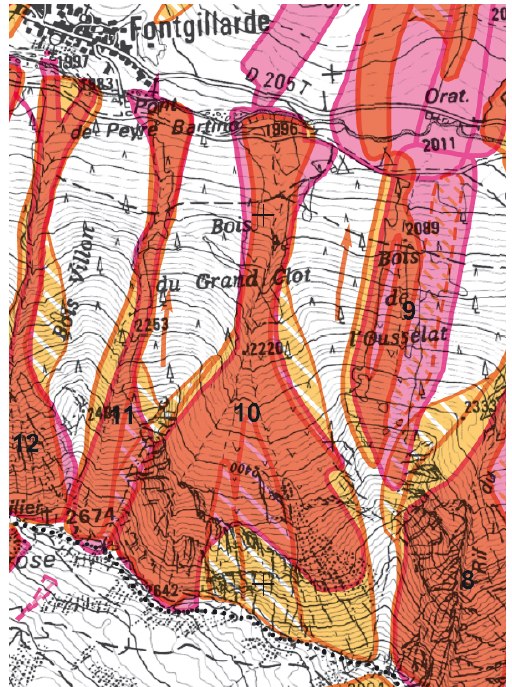
Figure 3. The Localization Map of Avalanche Phenomena (CLPA) in Molines-en-Queyras township. The CLPA path number 10 corre- sponds to the EPA path number 7 presented in Fig. 1. The avalanche extension limits obtained from eyewitness accounts are plotted in magenta. The yellow contours show avalanche extension limits based on photo-interpretations. Orange areas represent the intersec- tion of these two contours.